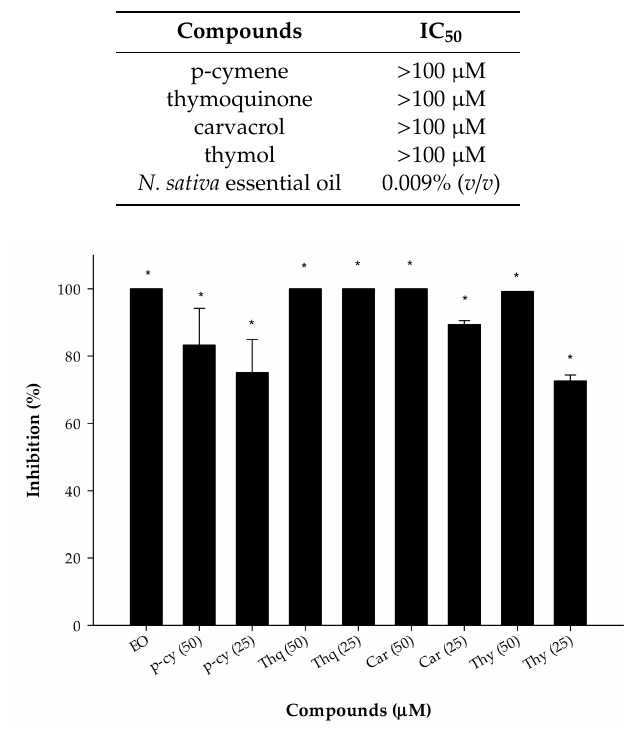
Figure 1. Anti-chlamydial e ff ects of compounds at 25 and 50 µ M. The N. sativa essential oil (EO) was tested at a concentration of 0.0025% ( v / v ). p-cy: p-cymene; Thq: thymoquinone; Car: carvacrol; Thy: thymol; * p < 0.05.